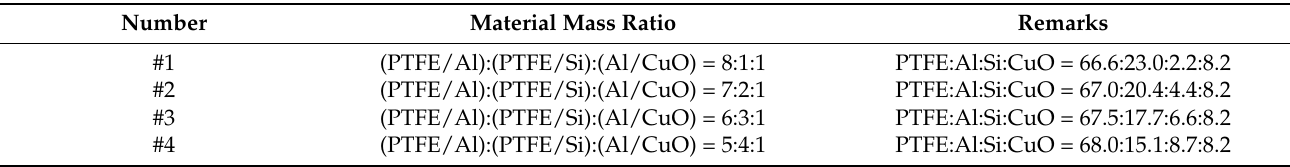
Table 2. Number and composition ratios of four specimens.